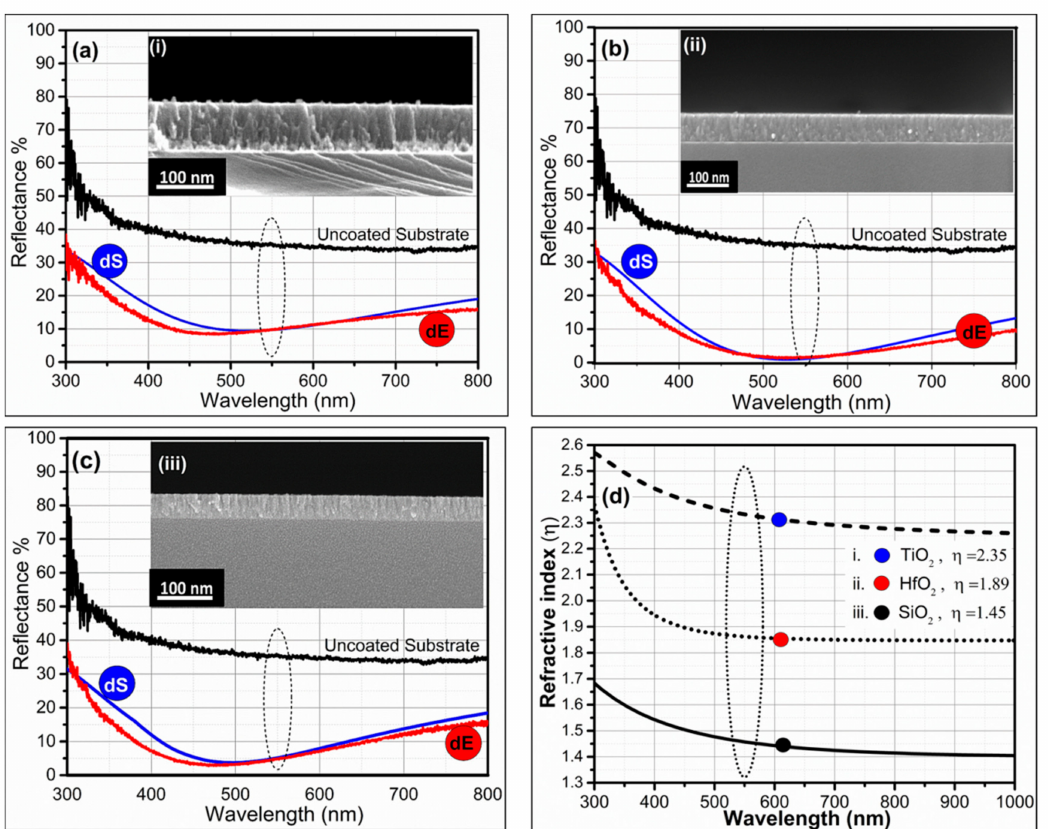
Figure 2. Experimental fabrication and simulation of single-layer AR coatings on silicon substrate ( a ) SiO 2 , ( b ) HfO 2 , and ( c ) TiO 2 . (The red curve represents the experimental reflectance (dE) curve, the blue curve represents the simulated reflectance (dS) of the model thin film, and the black curve represents the measured reflectance curve of the uncoated silicon substrate). ( d ) Refractive index of monolayer SiO 2 , HfO 2 , and TiO 2 coatings as a function of